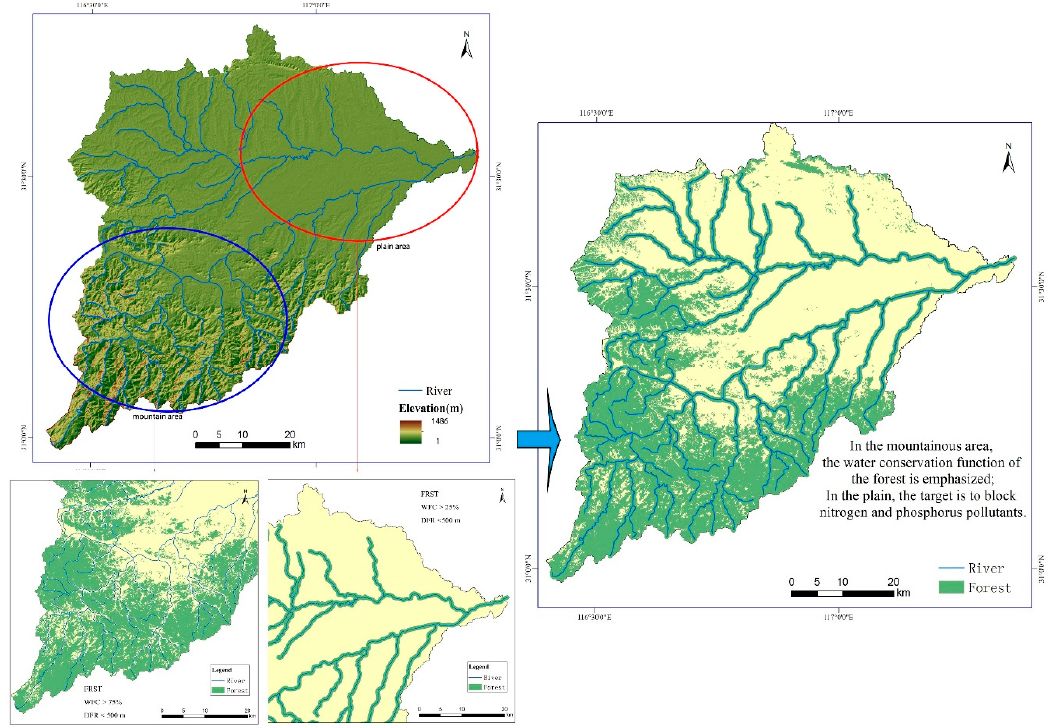
Figure 9. Optimized allocation of forest land oriented to NPS prevention.